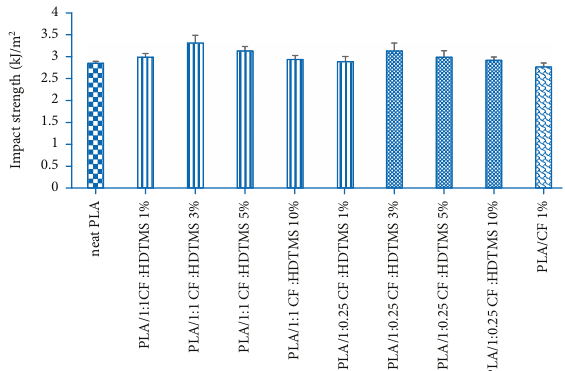
Figure 3: Impact strength values of PLA fi lled with hydrophobic composites at various CF/SiO 2